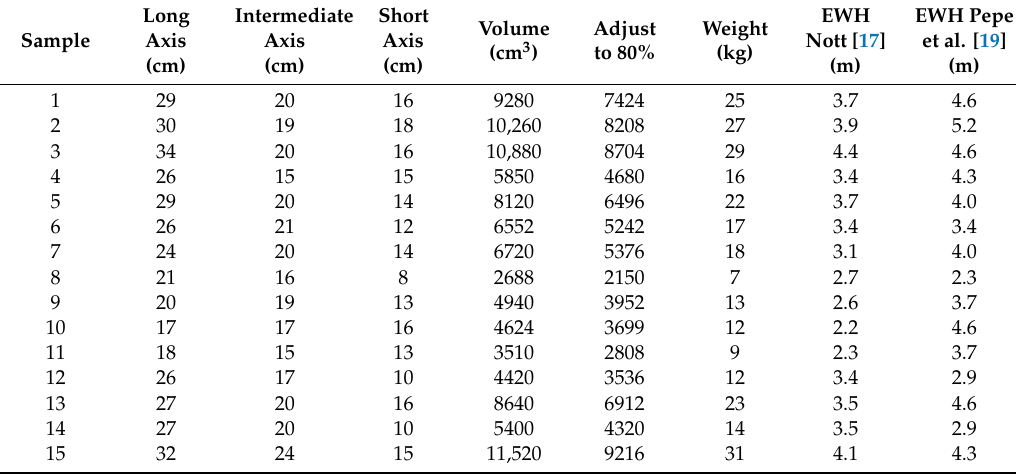
Table A3. Quantification of clast size, volume, and estimated weight from a sample on the NE flank of Støypet (Locality 3). The density of low-grade chromite at 3.32 g / cm 3 is applied uniformly in order to calculate wave height for each boulder. Abbreviation: EWH = estimated wave